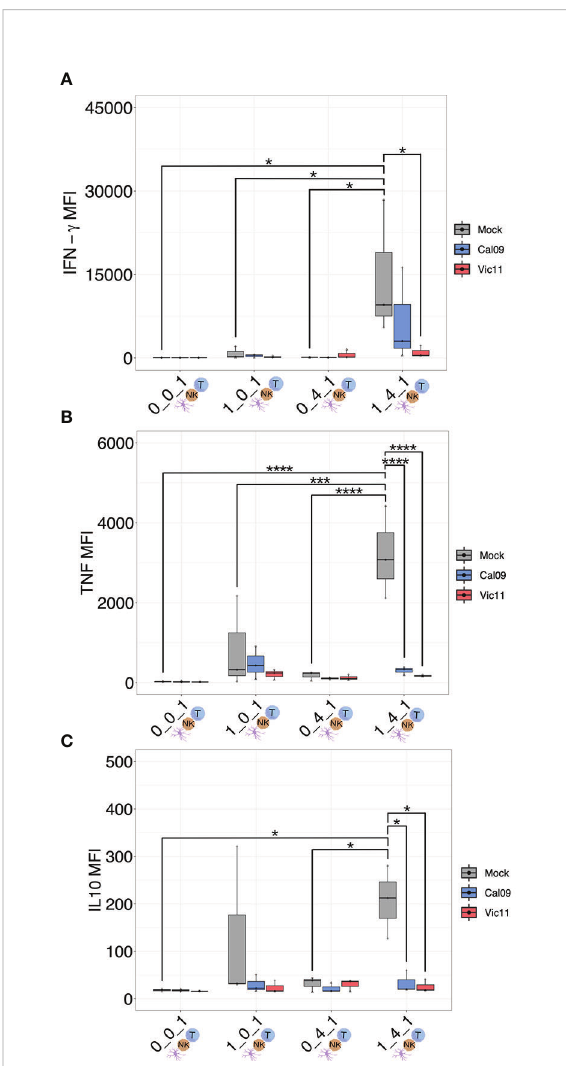
FIGURE 7 MoDC-NK cell cross-talk curtails the production of a broad array of cytokines as a result of in fl uenza exposure. (A) MAGPIX data showing the mean fl uorescence intensity (MFI) of (A) IFN- g , (B) TNF, and (C) IL-10 present in the supernatant of either mock- treated or virion-exposed T cells (0:0:1), T cells co-cultured with mock or virus-exposed MoDCs (MOI = 3, 96 HPI) (1:0:1), T cells co-cultured with mock or virion-exposed NK cells (0:4:1) or T cells co-cultured with both virus-exposed and mock MoDCs (MOI = 3, 96 HPI) and NK cells (1:4:1) ( n = 3). The same shape between conditions indicates that the data point is derived from the same donor. * p < 0.05, *** p < 0.0001, **** p < 0.0001. Two-way ANOVA, Prism